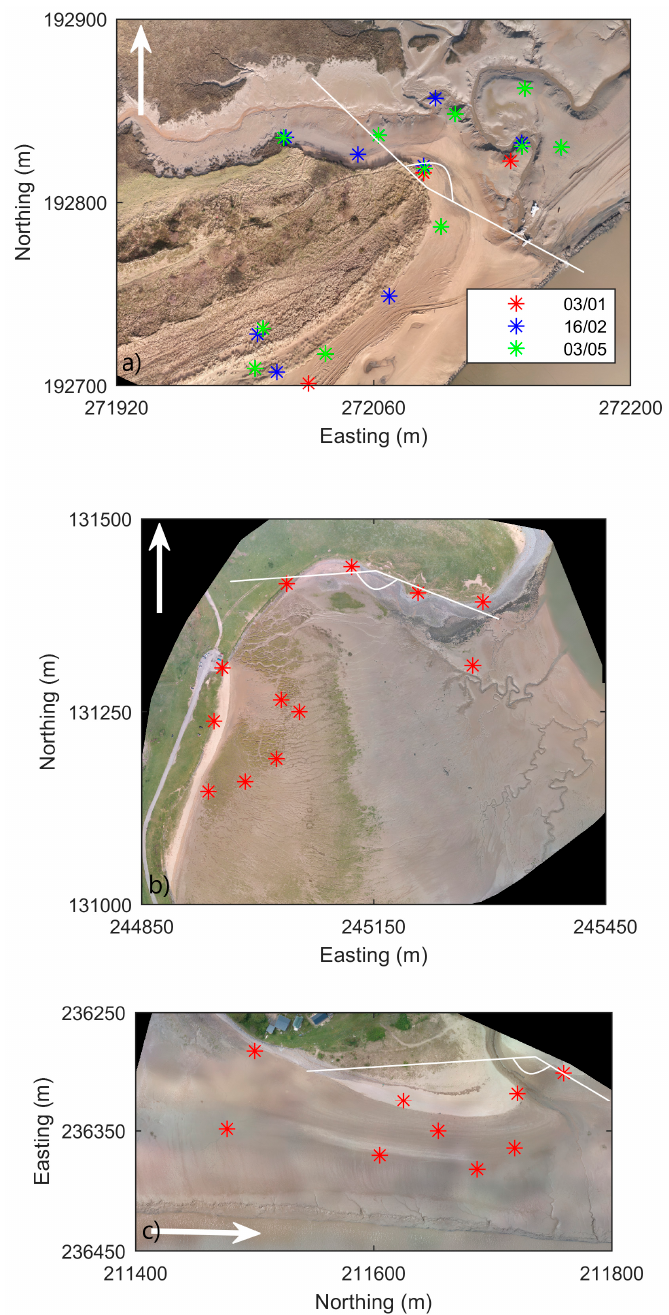
Figure 2. Orthomosaics of the Neath estuary site ( top ); the Appledore site ( middle ); and the Llansteffan site ( bottom ). North arrows are displayed in white for each image: for the top and middle plots North is in an upward direction while the bottom plot has been rotated 90° such that north is to the right. The position and extent of the panoramic photos shown in Figure 3 are displayed as thin white lines. Locations of ground control points are shown as asterisks; for the Neath study site (a), the different dates are displayed as different colors.